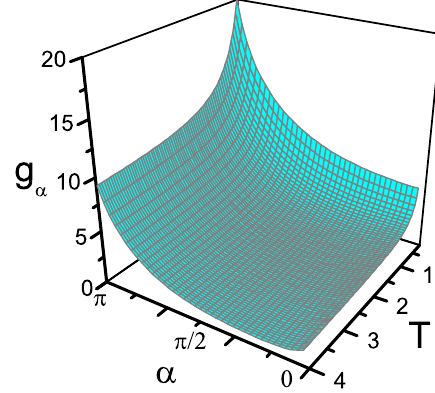
Fig. 2 The quantum parameter estimation with respect to α is evalu- ated by G α as a function of radiation temperature T when the frequency of Dirac field ω = 1 is chosen